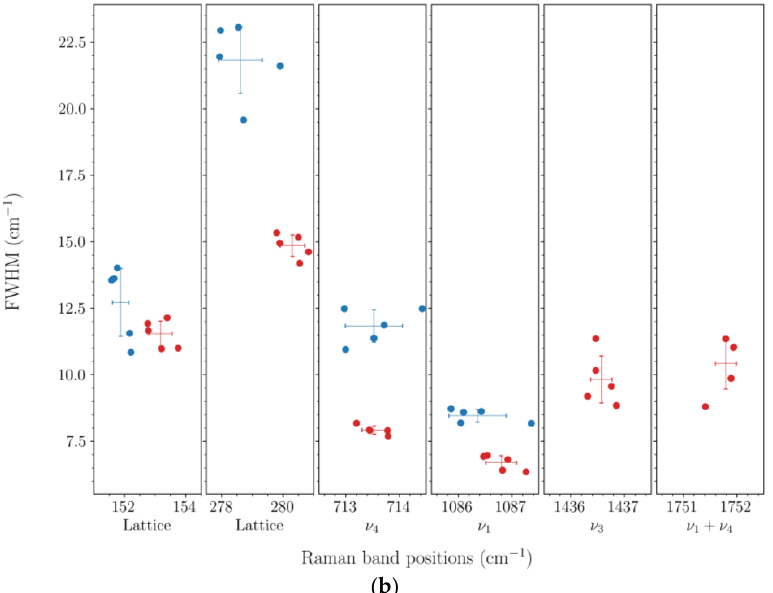
Figure 3. ( a ) Representative Raman spectra of the baseline and modified precipitates (see Section A of Supplementary Information for complete spectra). Calcite vibrational modes: (A, B) lattice modes; (C) ν 4 : doubly degenerate in- plane bending; (D) ν 1 : nondegenerate symmetric stretching; (E) ν 3 : doubly degenerate asymmetric stretching; (F) ν 1 + ν 4 . Note that the ν 1 mode of calcite is IR-inactive and the ν 2 mode (nondegenerate out-of-plane bending) is Raman inactive. ( b ) Positions and widths of calcite peaks in the Raman spectra acquired from five locations each in the baseline and modified precipitates. Red markers represent the baseline precipitate and blue markers represent the modified precipitate.